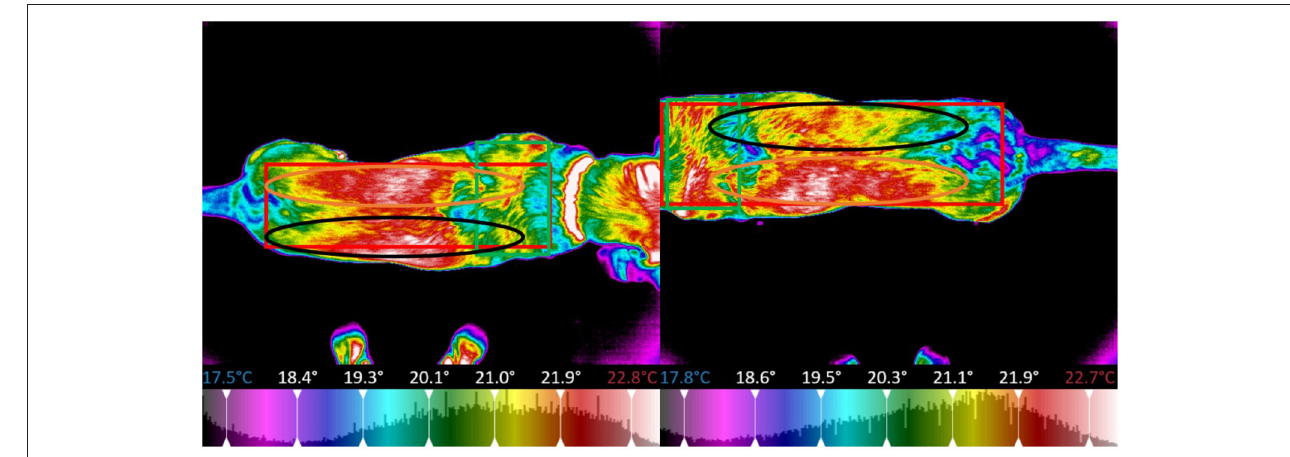
FIGURE 8 | Sectioned muscle regions dorsal view (Left, pre-exercise; Right, post-exercise).